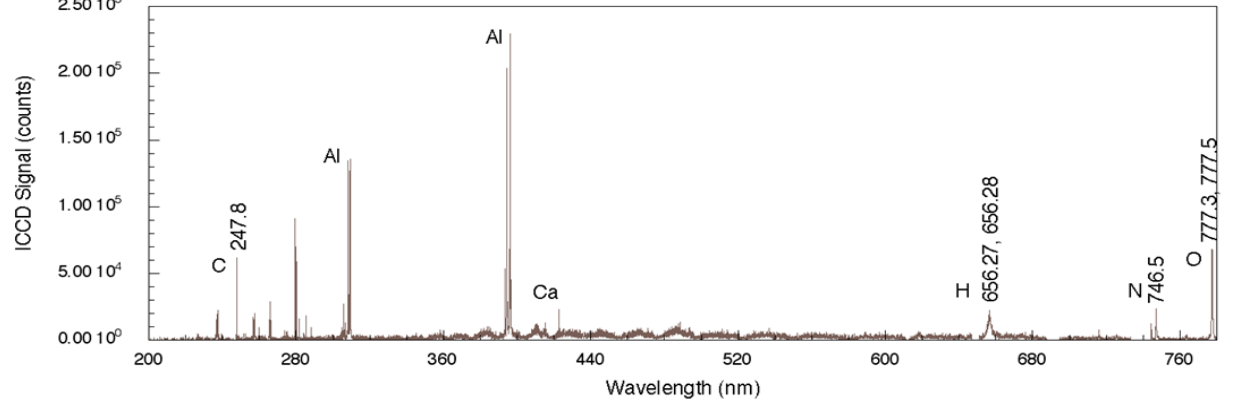
Figure 2. Nanosecond LIBS signal obtained from TNT on an aluminum substrate. Prominent emission lines from the substrate are present along with lines associated with TNT (C, H, N, O) and contaminants